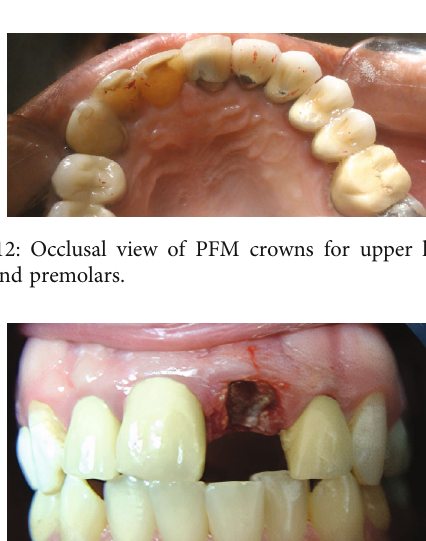
Figure 11: Buccal view of PFM crowns for upper left lateral, canine, and premolars.